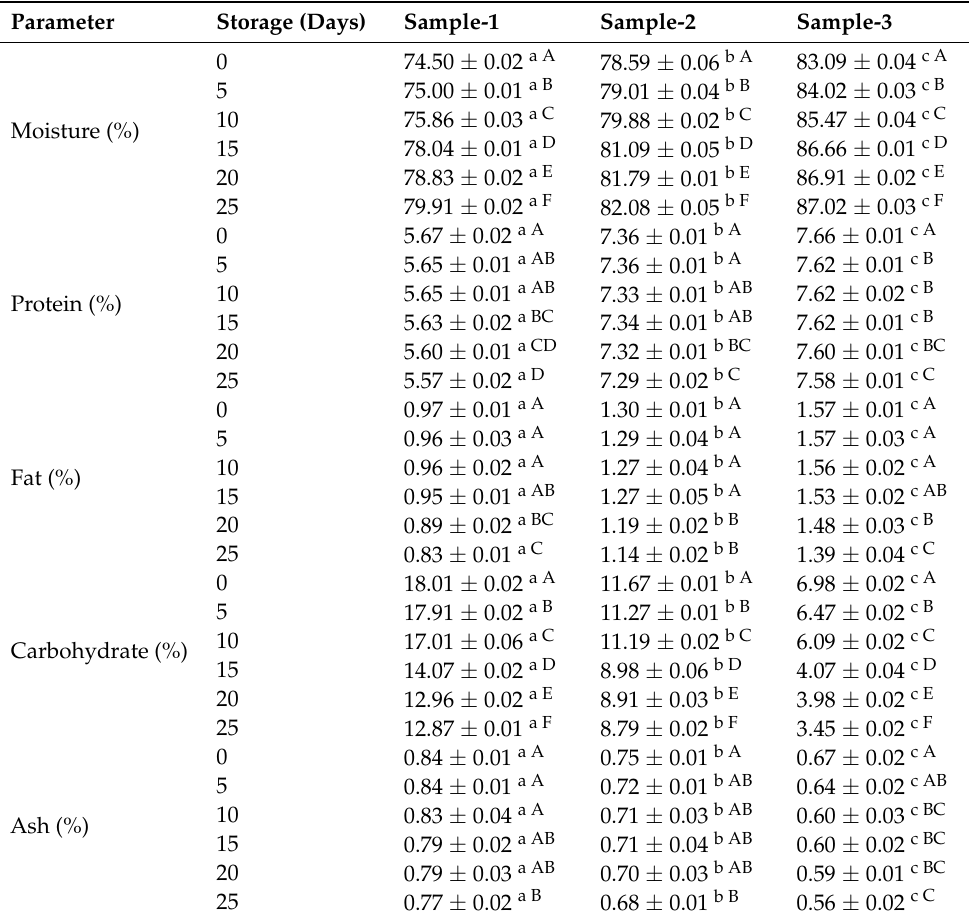
Table 3. Physicochemical analysis of whey-mango based mixed beverage 1